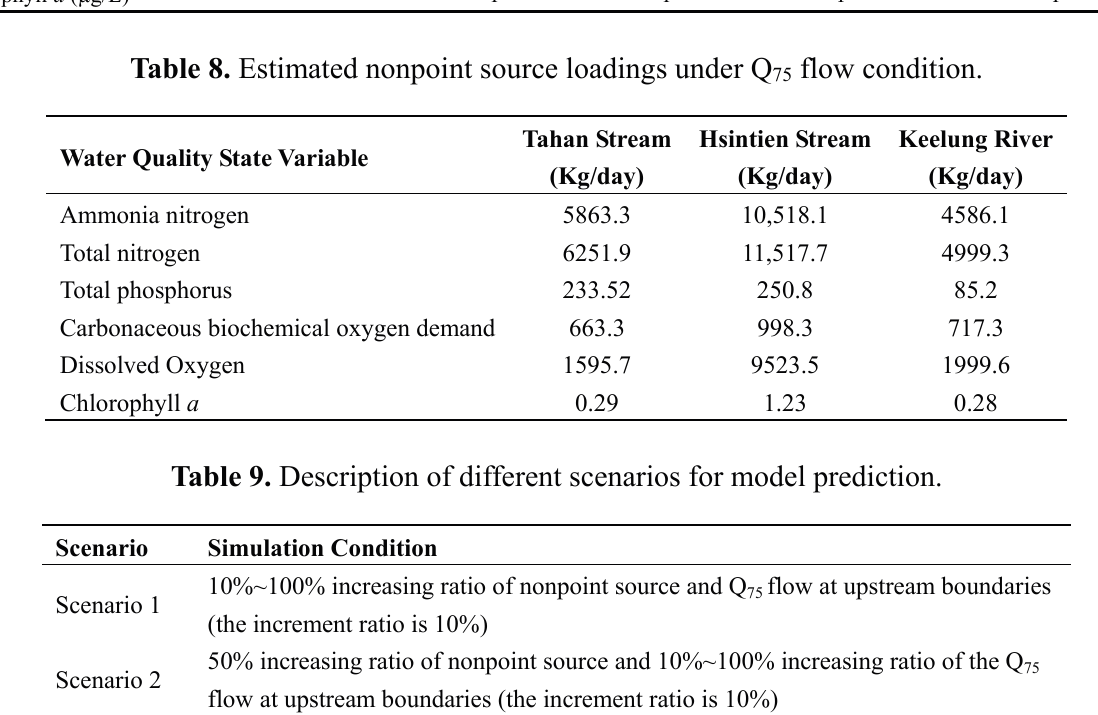
Table 8. Estimated nonpoint source loadings under Q